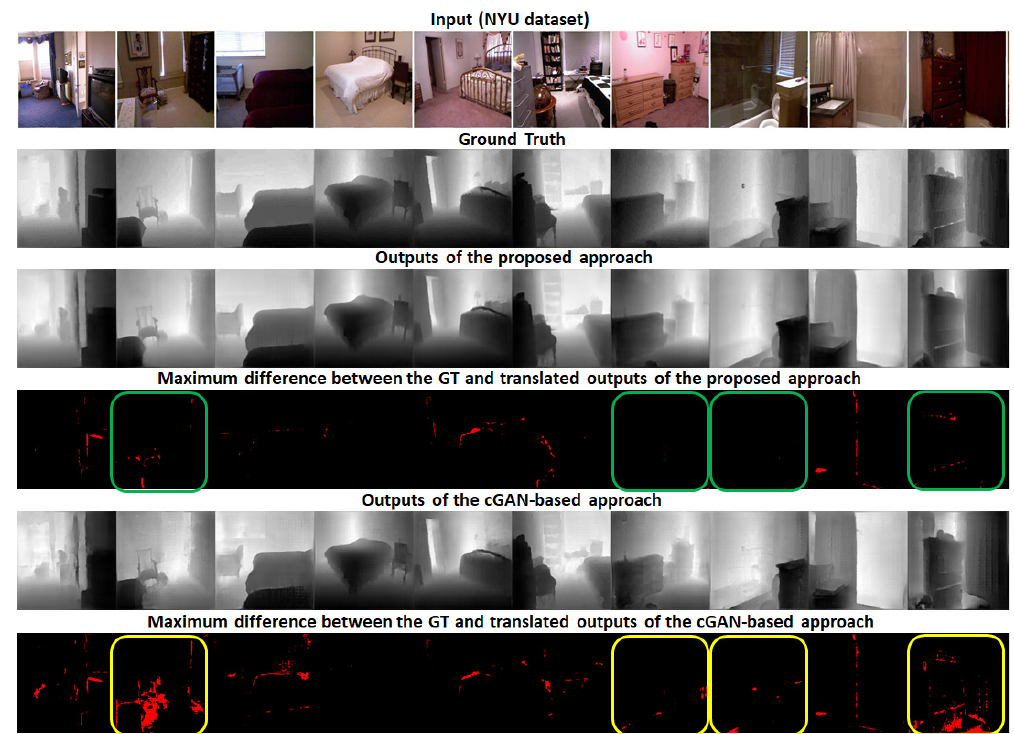
Figure 5. Comparative analysis of the proposed approach with cGAN [10] with emphasis on the high-error regions using the NYU dataset.